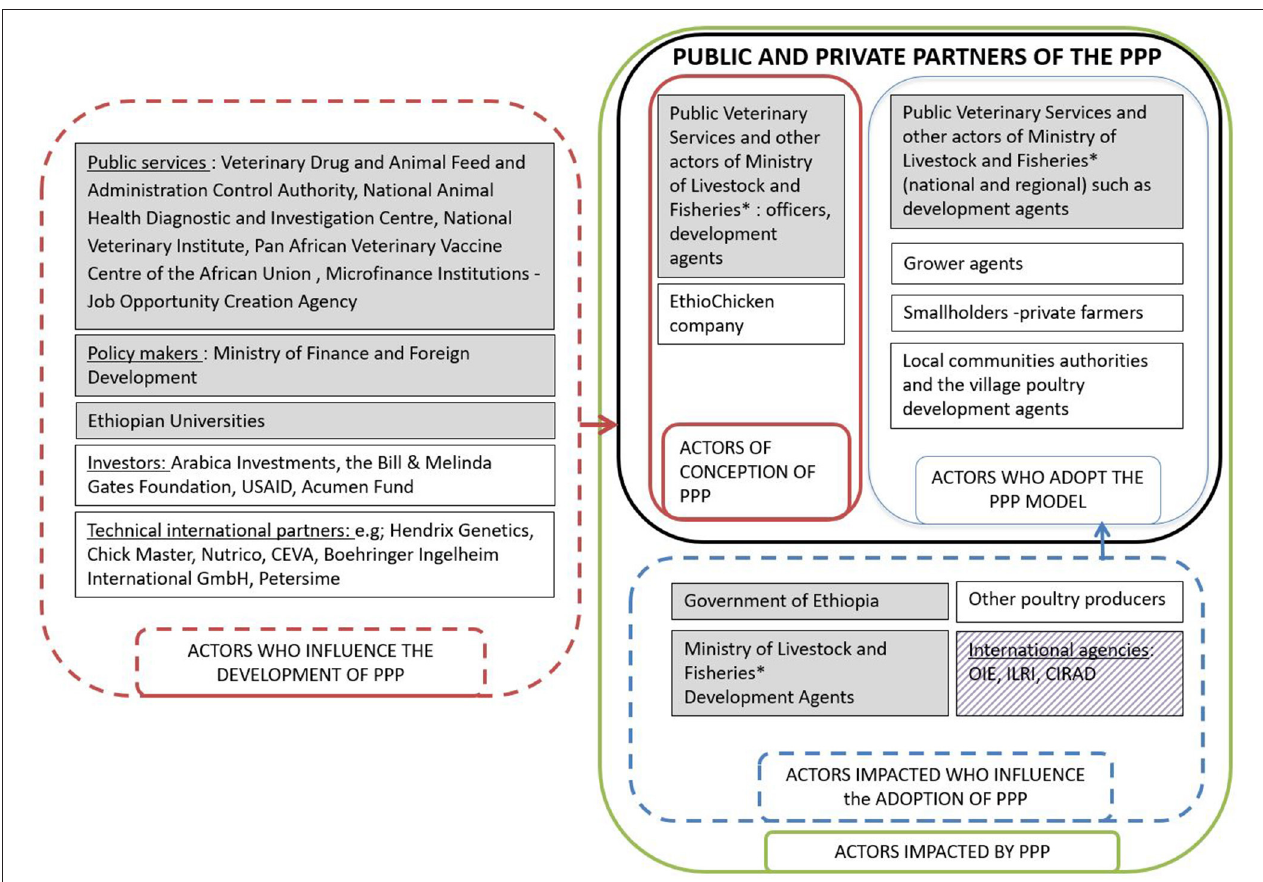
FIGURE 3 | Mapping of categories of the actors involved directly or indirectly in the PPP between EthioChicken and the public Veterinary Services. The dark-gray rectangles indicate the public actors. The white rectangles indicate the private actors. The light-gray rectangle indicates international agencies. *The Ministry of Livestock and Fisheries has merged with Ministry of Agriculture since April 2018. CIRAD, French Agricultural Research Center for International Development; OIE, World Organization for Animal Health; PPP, Public–Private Partnership; USAID, United States Agency for International Development.